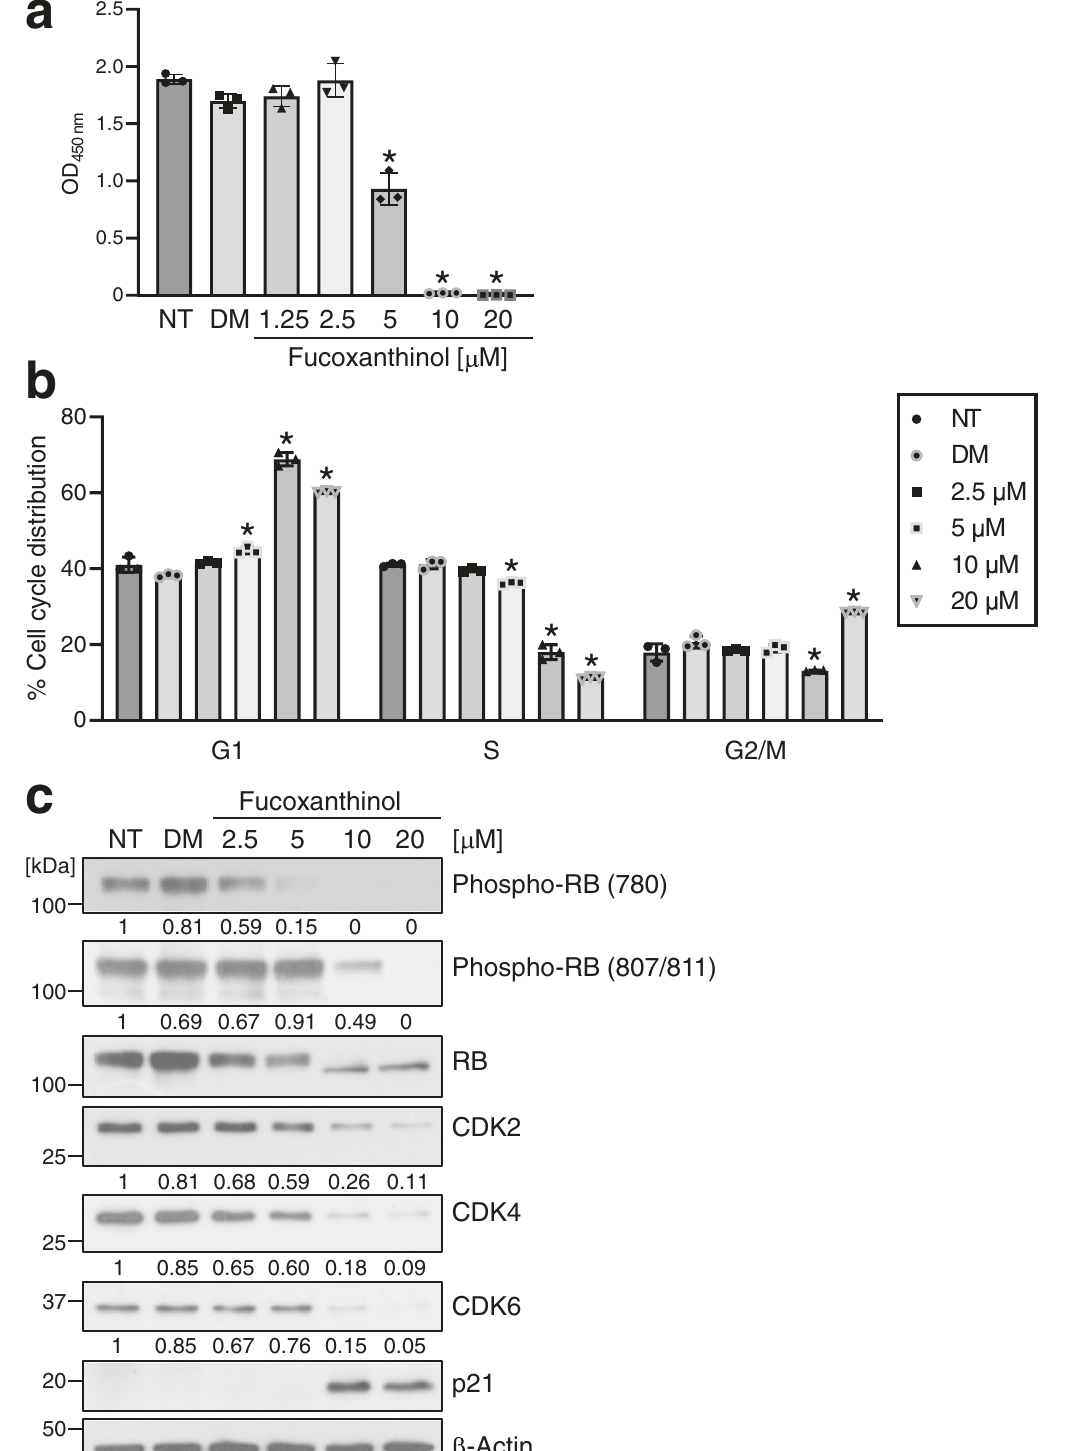
Fig. 1 Fucoxanthinol induces G1 cell cycle arrest with the downregulation of CDK2, 4, and 6 protein expression. a Human colon cancer HT-29 cells were treated with the indicated doses of fucoxanthinol for 72 h. The proliferation of cells was measured using the CCK-8 assay. b HT-29 cells were treated with fucoxanthinol for 24 h, and the cell cycle was analyzed by fl ow cytometry. c A western blot analysis of HT-29 cells treated with fucoxanthinol for 24 h. The signal of each western blot was quanti fi ed using ImageJ software (Version 1.52a) and normalized by the value of β -actin. The value of each signal was indicated below the blot. NT: non-treated, DM: 0.1% DMSO, Data are means ± S.D. ( n = 3 biologically independent experiments). * P < 0.05 signi fi cantly different from